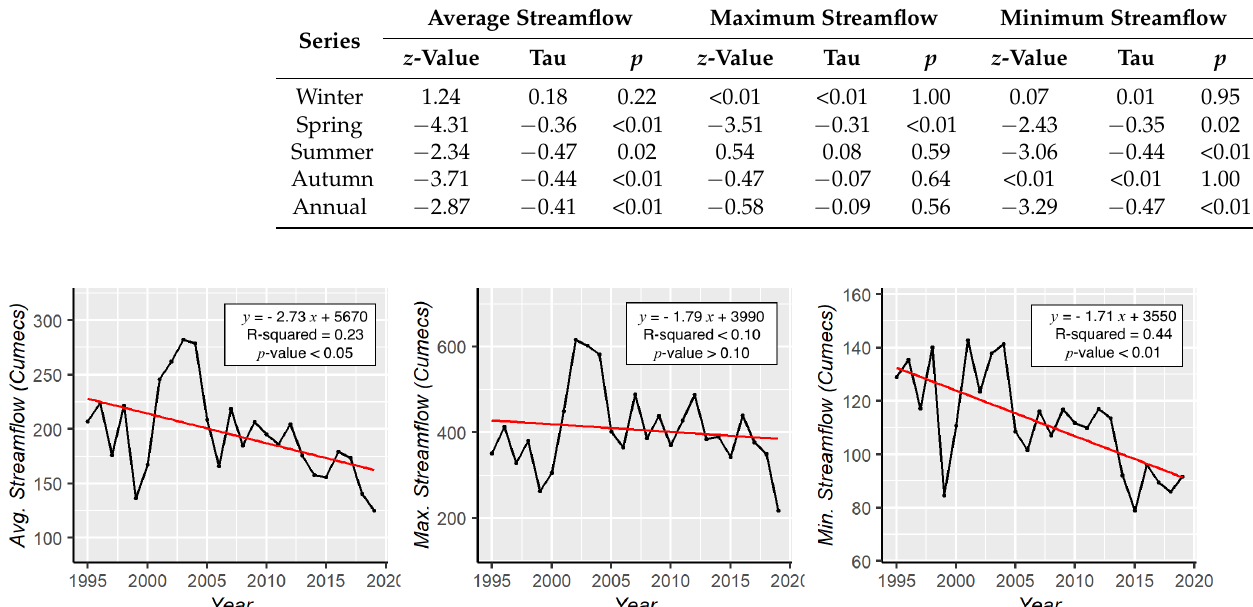
Table 6. Summary of the modified Mann–Kendall statistical tests of streamflow.